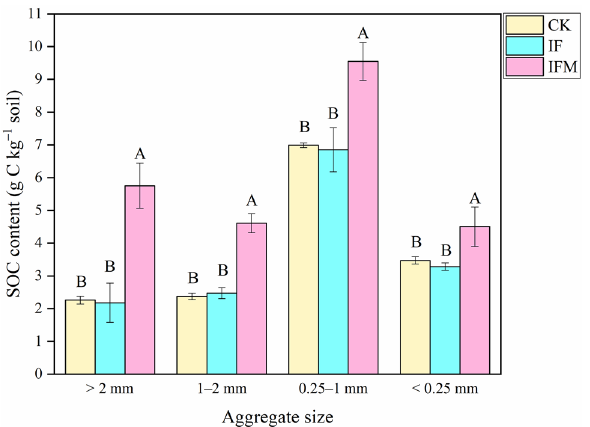
Figure 1. Effects of 29-year long-term fertilization on SOC content in soil aggregates. Note : The CK denotes the no fertilization control treatment, IF inorganic fertilizer treatment, and IFM inorganic fertilizer plus manure treatment. Vertical bars represent the standard error of the mean significant variations (SEM; n = 3). Values followed by different letters mean significant variations ( P < 0.05) in SOC content among various fertilizer management strategies for the same aggregate